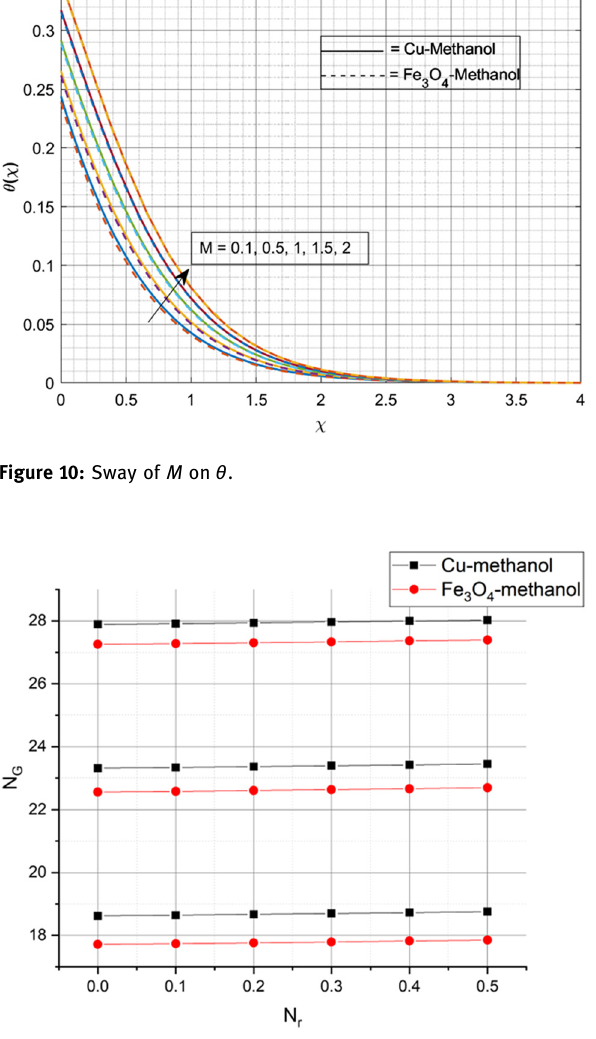
Figure 11: Sway of N r on NG.